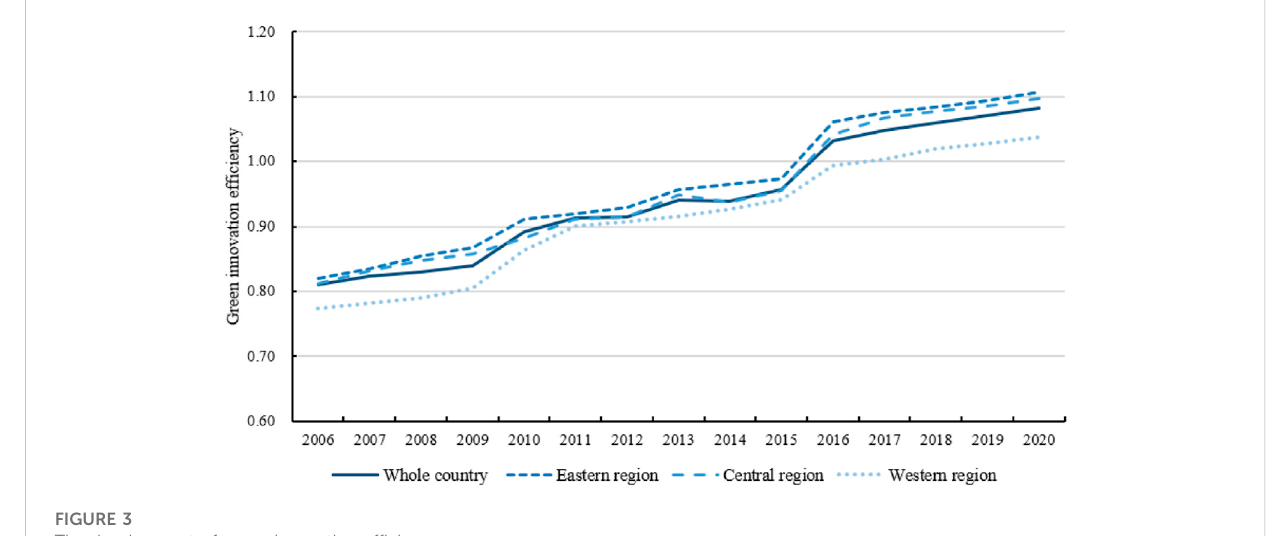
FIGURE 3 The development of green innovation ef fi